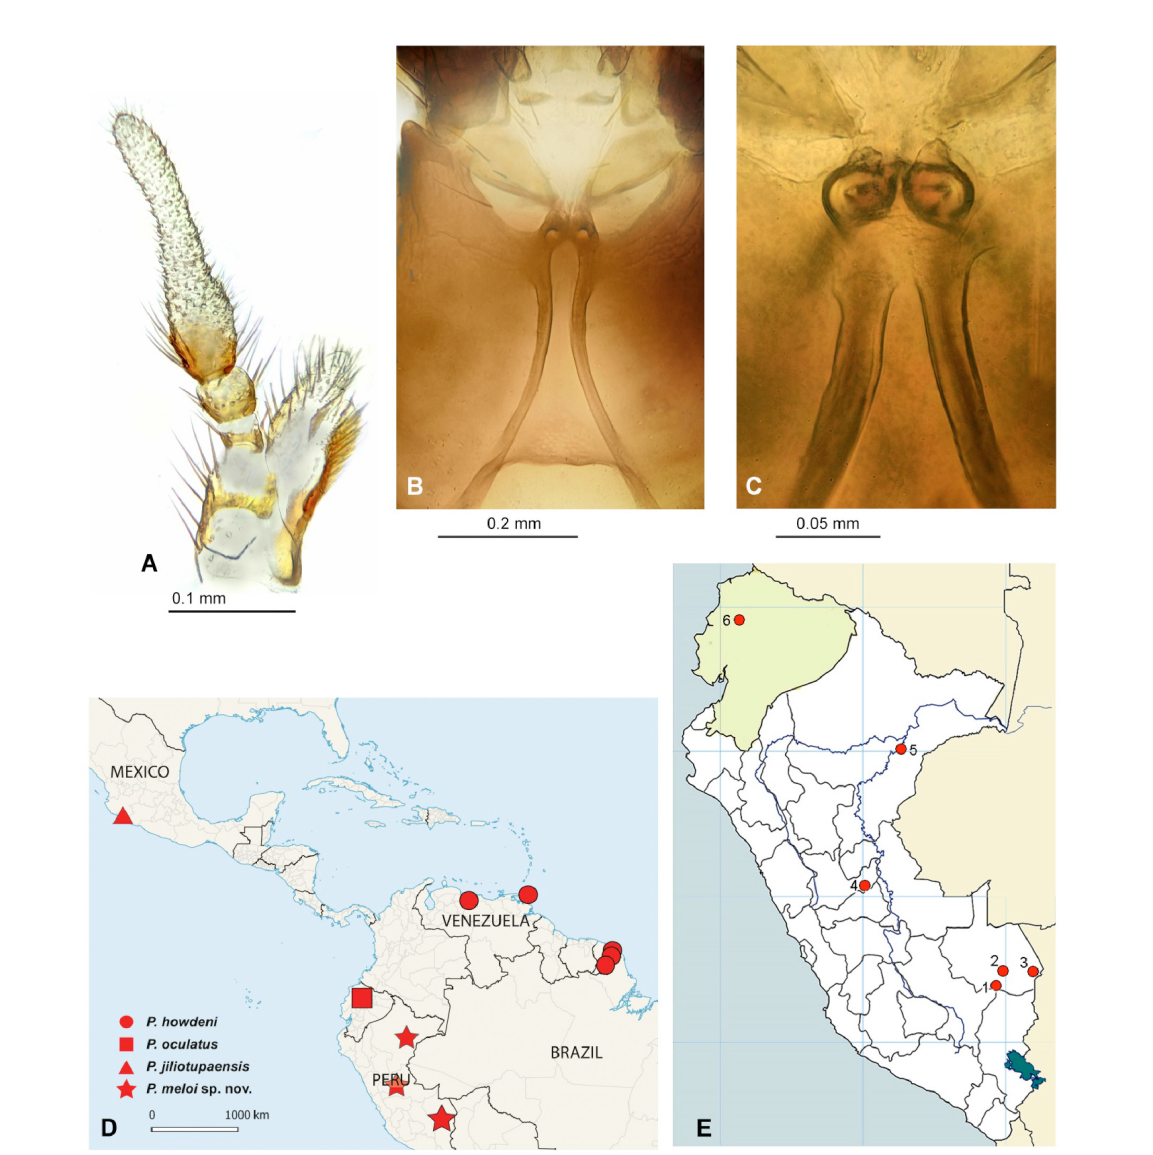
Fig. 3. A . Pseudotelegeusis meloi sp. nov., right maxillar palpi, ventral view. B . Pseudotelegeusis meloi sp. nov., tentorial pits, ventral view. C . Pseudotelegeusis howdeni Wittmer, 1976, tentorial pits, ventral view. D . Distribution map of the genus Pseudotelegeusis Wittmer, 1976. E . Distribution